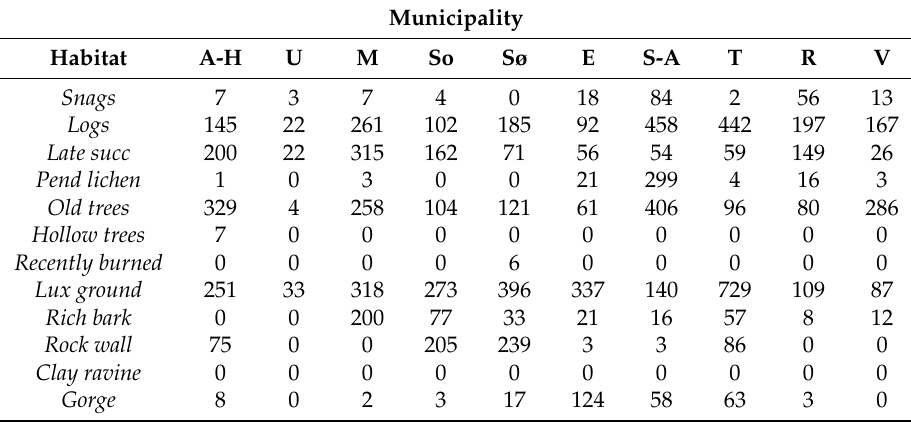
Table 1. The number of different CHI (Complementary Habitat Inventory) habitats recorded in 10 municipalities. A-H = Aurskog-Høland, U = Ullensaker, M = Marnardal, So = Songdalen, Sø = Søgne, E = Etnedal, S-A = Sør-Aurdal, T = Tokke, R = Rendalen, V = Vinje. Late succ = Late succession of deciduous trees , Pend lichen = Pendant lichens , Lux ground = Luxuriant ground vegetation , Rich bark = Trees with nutrient-rich